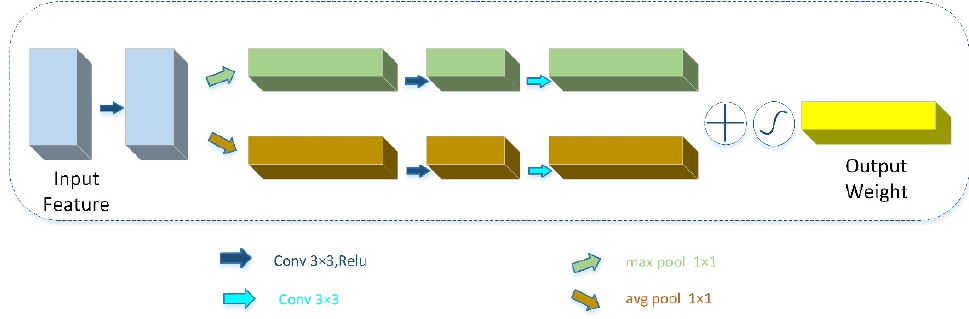
Figure 5. The structure of the convolution block channel attention module.